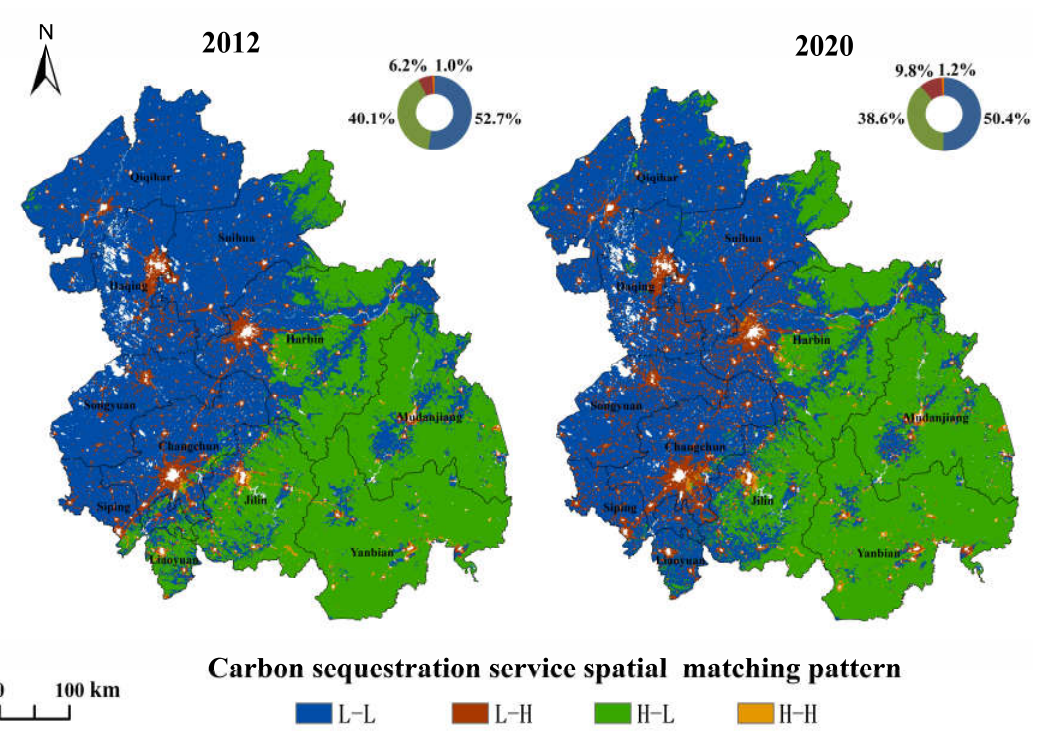
Figure 9. The spatial matching pattern of supply and demand.